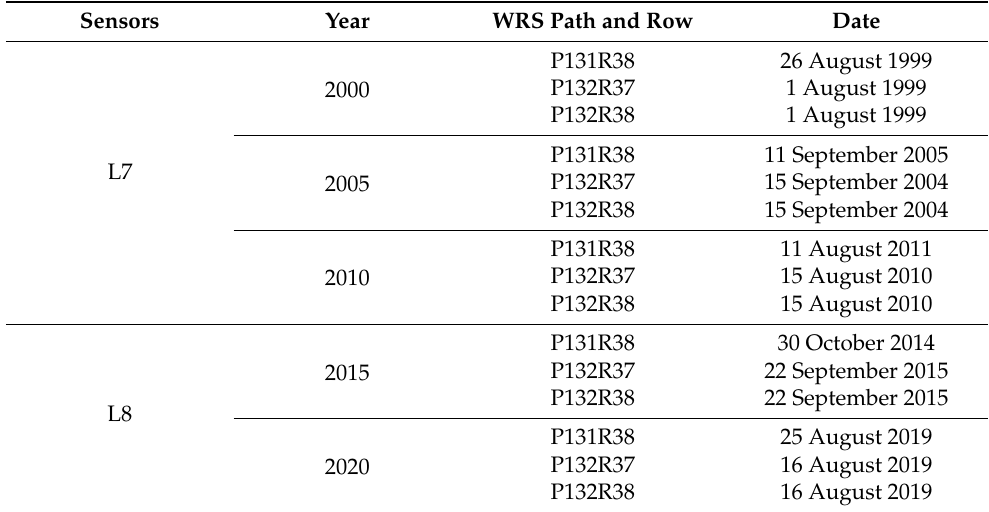
Table 1. Landsat data collection table. Sensors WRS Path and